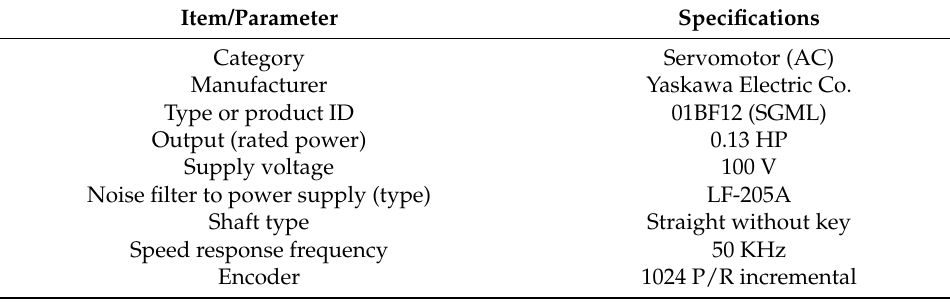
Table 1. Specifications of the servomotor with encoder.